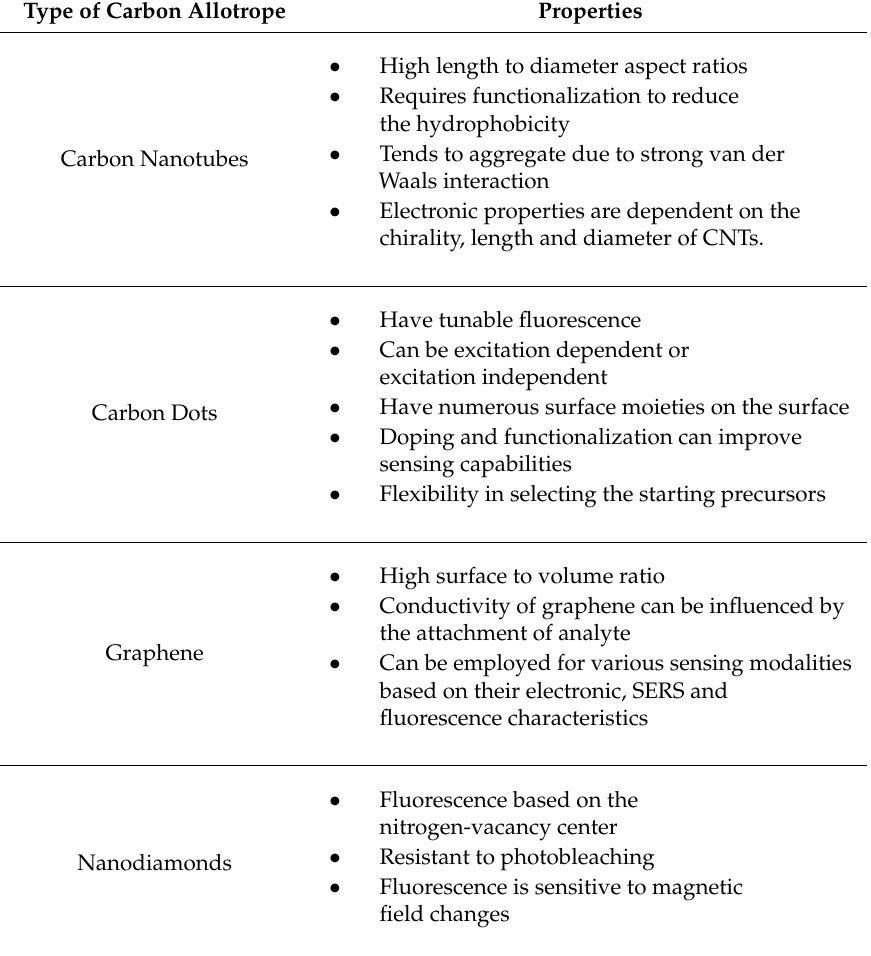
Figure 2. ( a ) N-V center in NDs. N and C are colored in red and black, respectively while vacancy is represented by yellow. The x and y-axes are shown on top of the z-axis. ( b ) The electronic states of NDs at room temperature. As a result of the double degeneracy of the molecular orbitals of the excited spin-triplet state, there are two orthogonal transition dipole moments. Spin-preserving PL and optical excitation are illustrated by green and red arrows, respectively [69]. Copyright © 2017, Elsevier. Table 1. Comparison of carbon allotropes properties.